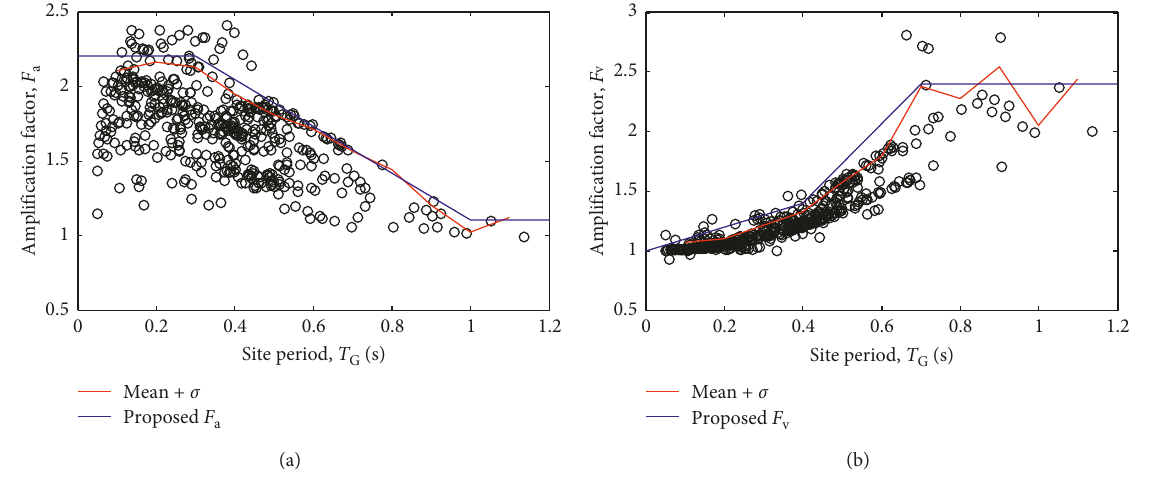
Figure 13: Site amplification factors according to site period (DRS-2): (a) F